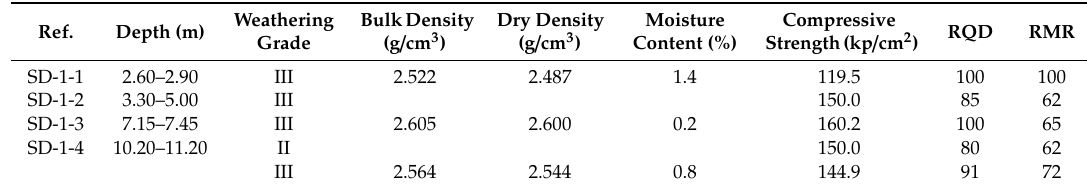
Table 1. Granitic rock